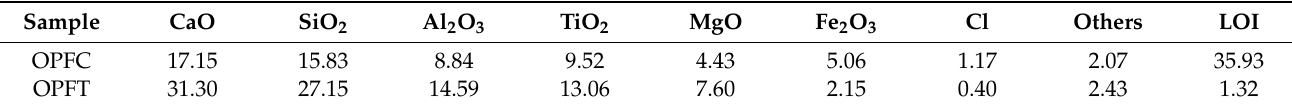
Table 3. Chemical composition of OPFC and OPFT samples